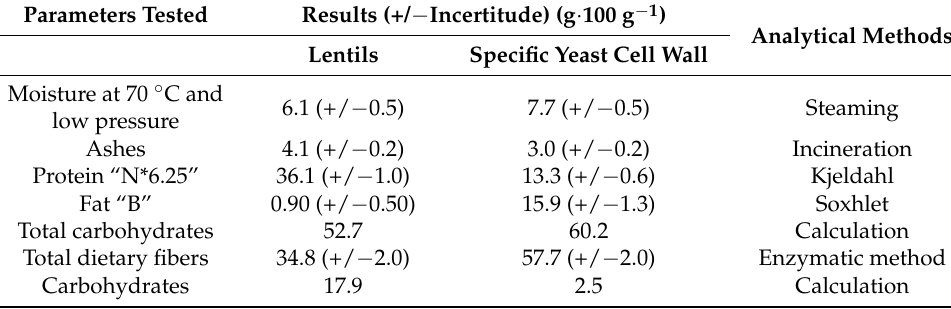
Table 1. Detailed composition of the two fiber-containing products that were tested. Parameters